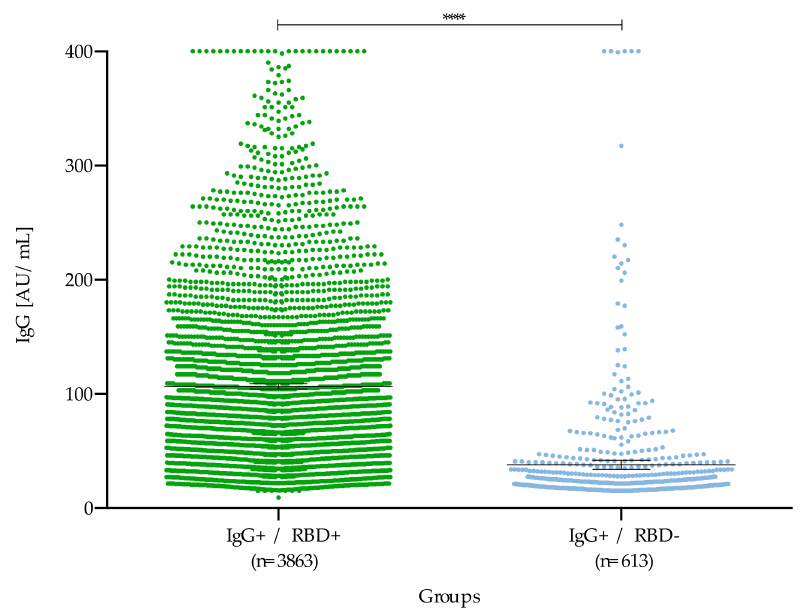
Figure 5. Comparative analysis of double-positive samples (IgG+/RBD+) and that did not show neutralization (IgG+/RBD-). The mean of the groups with neutralizing (IgG+/RBD+) and non-neutralizing (IgG+/RBD-) antibodies was 106.5 AU/mL and 37.7 AU/mL respectively. **** p <